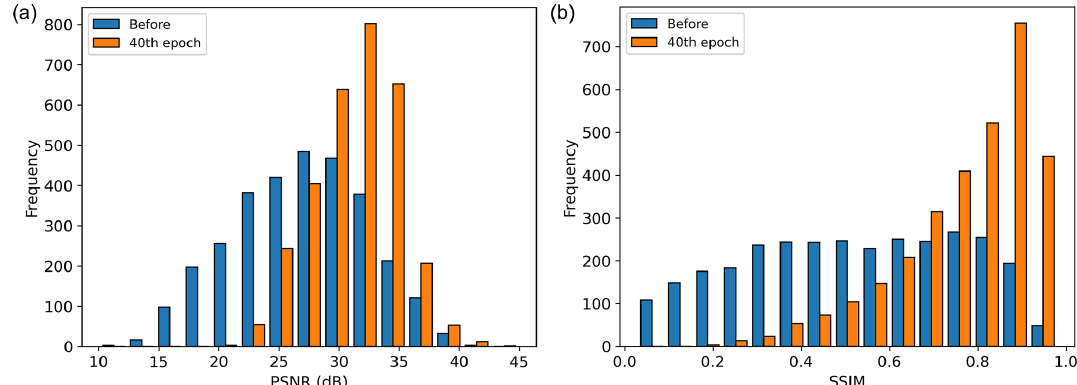
Figure 9. (a) PSNR and (b) SSIM histogram of the test data before applying the D1 model and after applying the 40th epoch of the D1